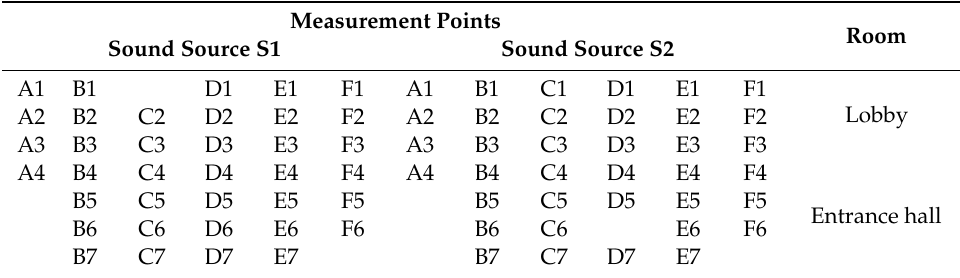
Figure 6. The frequency response of one loudspeaker unit of the omnidirectional loudspeaker. Table 5. Measurement points of the sound pressure distribution.